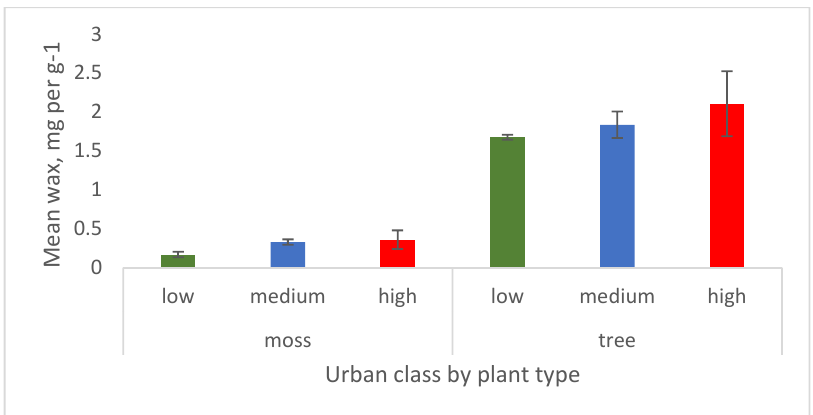
Figure 6. Mean wax on moss and tree leaf showing trend with increasing urban class. Wax is measured in mg per g dry weight. Error bars are ± 1 standard error.